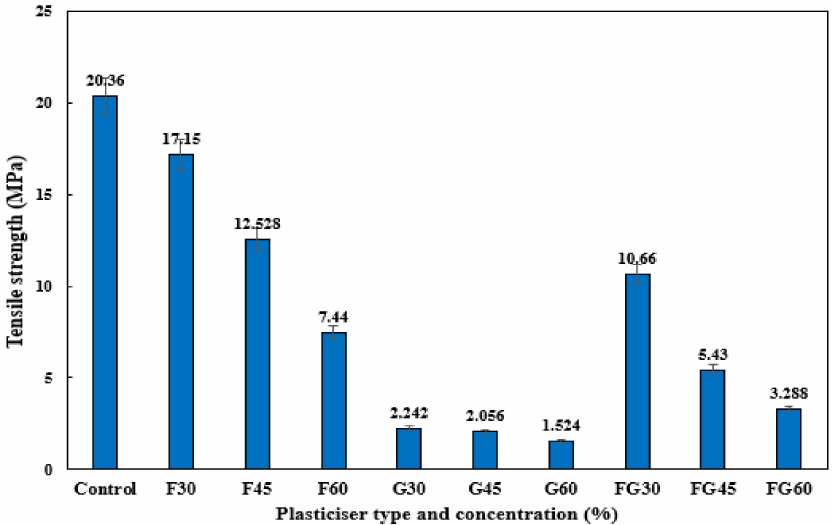
Figure 7. Tensile strength analysis of corn starch film with various plasticizers type at different concentra- tions: F30–F60: F-plasticized film; G30–G60: G-plasticized film; and FG30–FG60: FG-plasticized